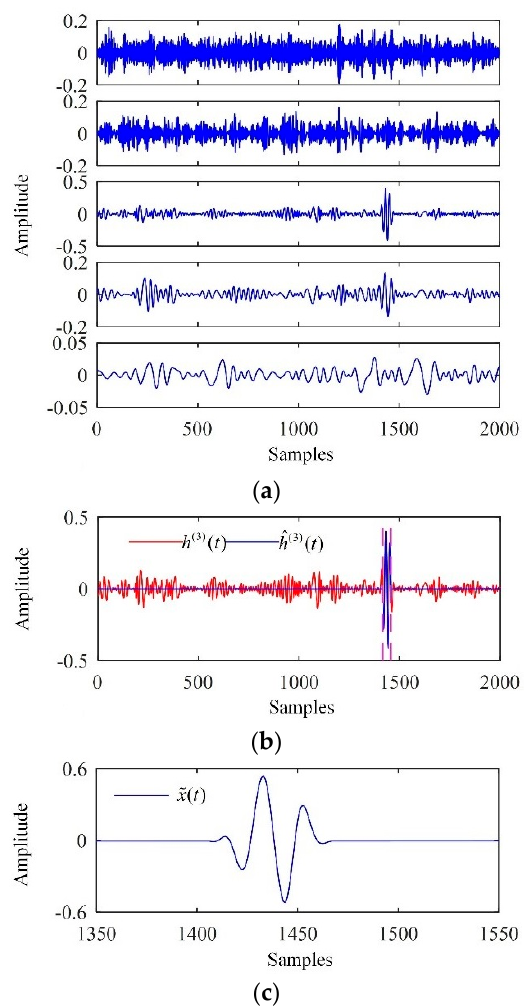
Figure 6. The ultrasonic signals. ( a ) Acquired from F1; ( b ) acquired from F2. Table 3. SampEn of the first five IMFs.